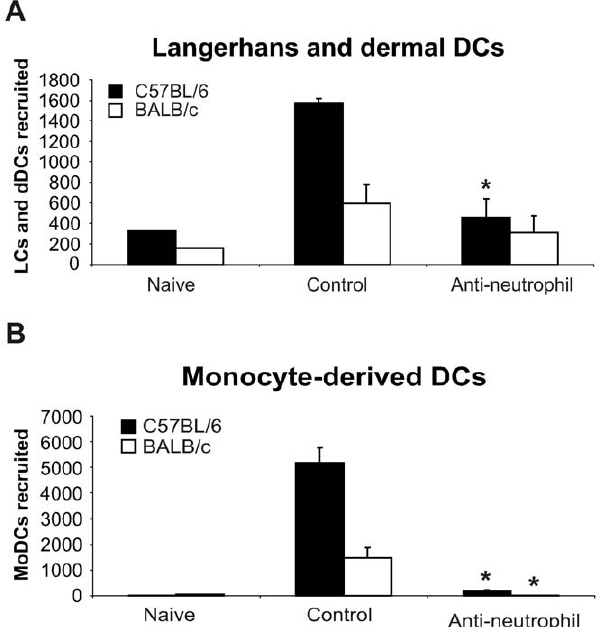
Figure 3. Neutrophils are essential for DC recruitment to the ear dermis following L.major promastigote inoculation. C57BL/6 and BALB/c mice were depleted of neutrophils by an injection i.p. of the NIMP-R14 anti-neutrophil mAb, or injected with a control mAb, 6 hours prior to infection i.d. with L. major stationary promastigotes. The number of (A) Langerhans and dermal DCs and (B) monocyte-derived DCs recruited in the ear dermis at 0h (naı¨ve) or 24h following L. major inoculation was quantified and compared in mice depleted or not of neutrophils. Data are given as mean values 6 SEM (n=6 per group) and are representative of three experiments. * : p , 0.05 between mice depleted or not of neutrophils.